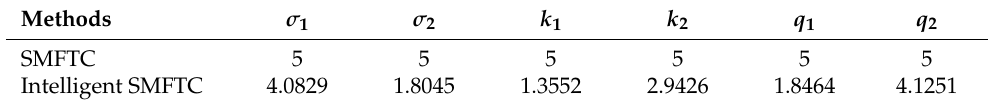
Table 1. Designable parameters in controllers for aircraft engine.